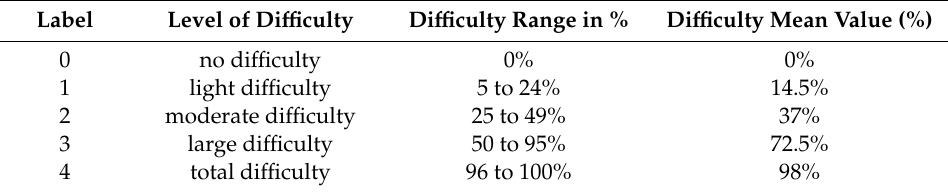
Table 5. Di ffi culty percentage ranges per category and mean value taken for quantitative